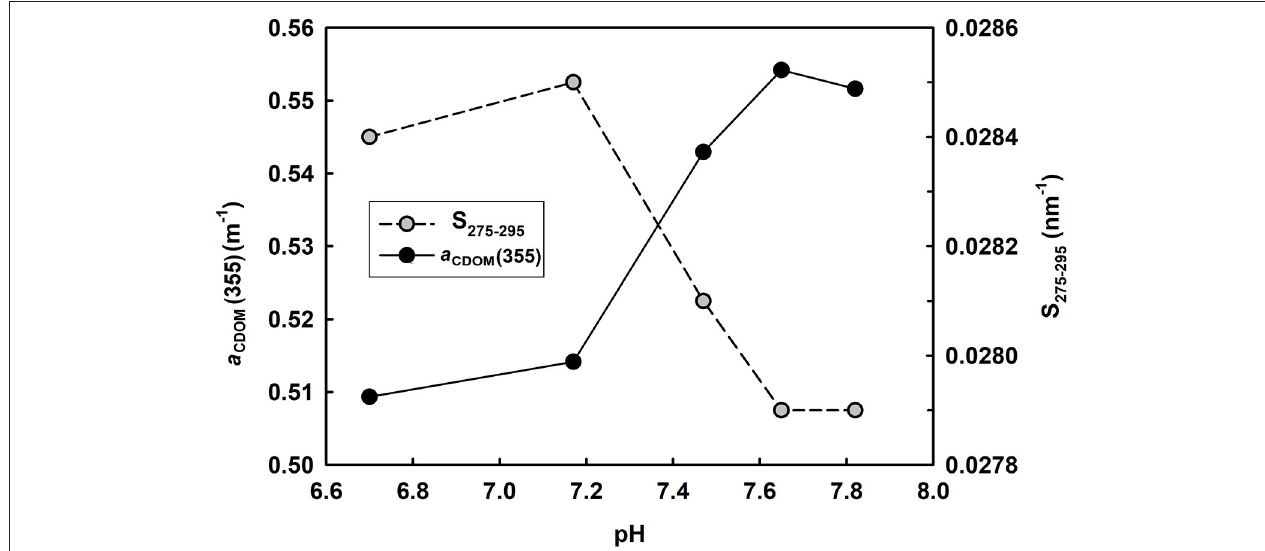
FIGURE 8 | Variation of a CDOM (355) and S 275 − 295 with changing pH. Water sample was taken from the mariculture area with an initial pH 7.82.